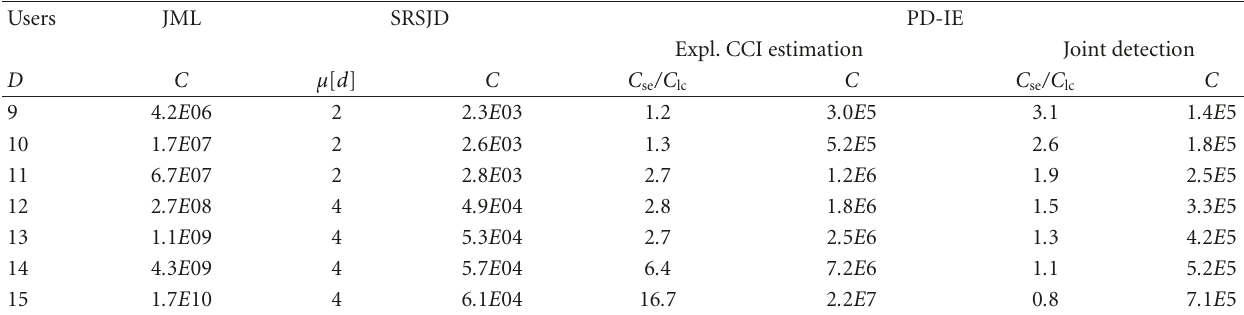
Table 2: Comparison of computational complexity for a receiver with an M = 8-element UCA.